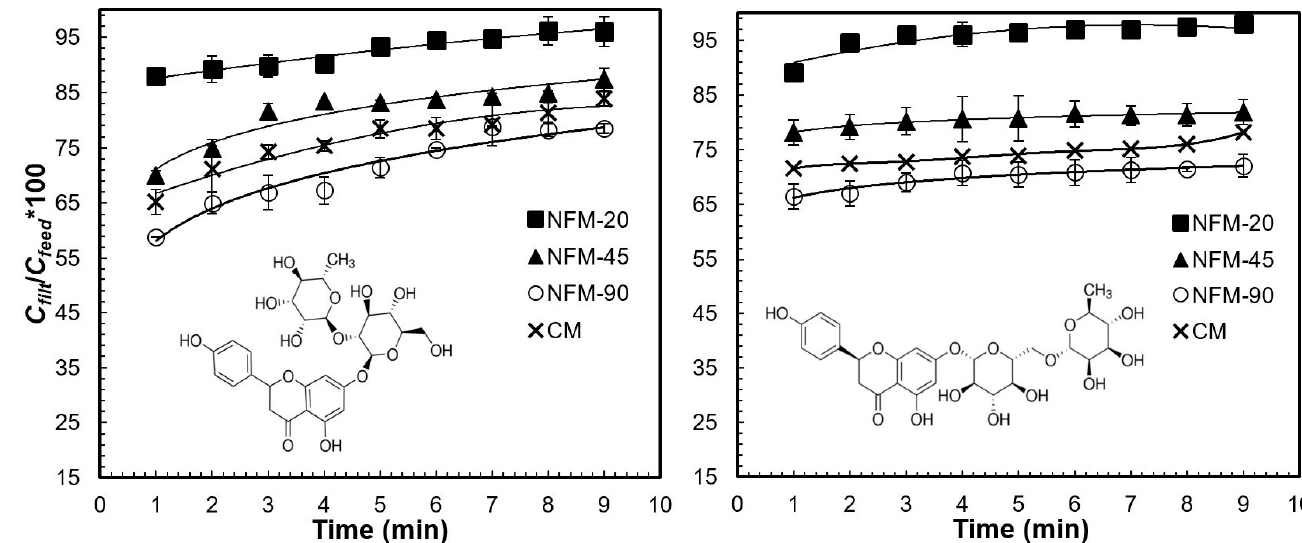
Figure 2. Change in concentration of standard solutions of typical Citrus glycosylated antioxidant compounds: ( left ) naringin and ( right ) narirutin during filtration with nylon-6 nanofibrous membranes of different thickness and nylon commercial membrane (CM). Vertical error bars correspond to standard deviations of n = 3 repetitions.